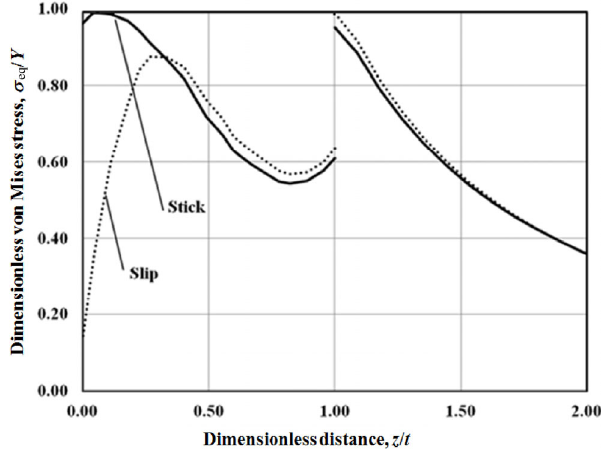
Fig. 8 Dimensionless von Mises equivalent stress along the axis of symmetry ( t/R = 0.0045, E co /E su = 4,  y_su =  y_co = 0.001,  / R = 6.5 × 10 − 6